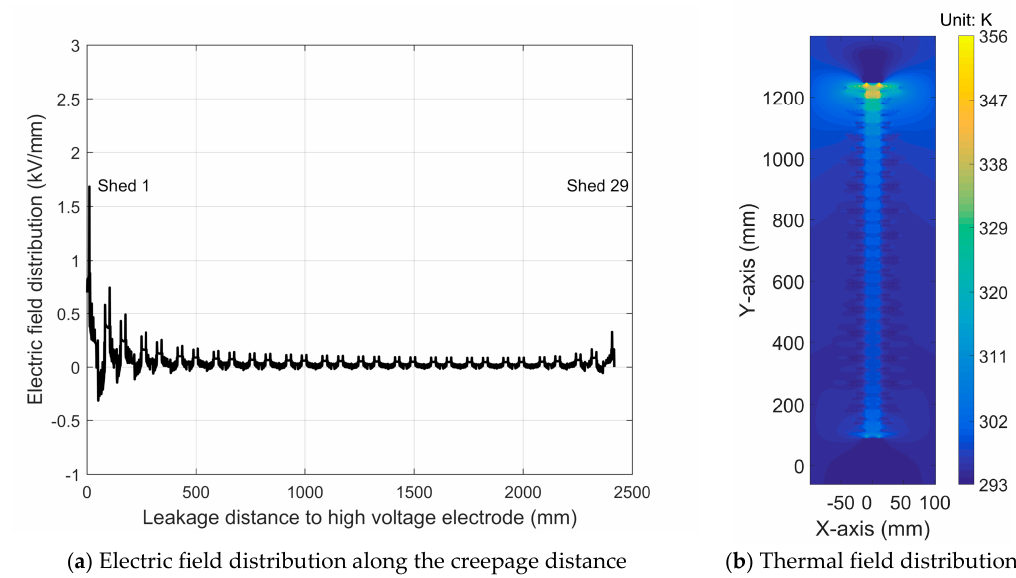
Figure 4. Electric and thermal field distributions before the pollutant layer generation. ( t = 0 s).